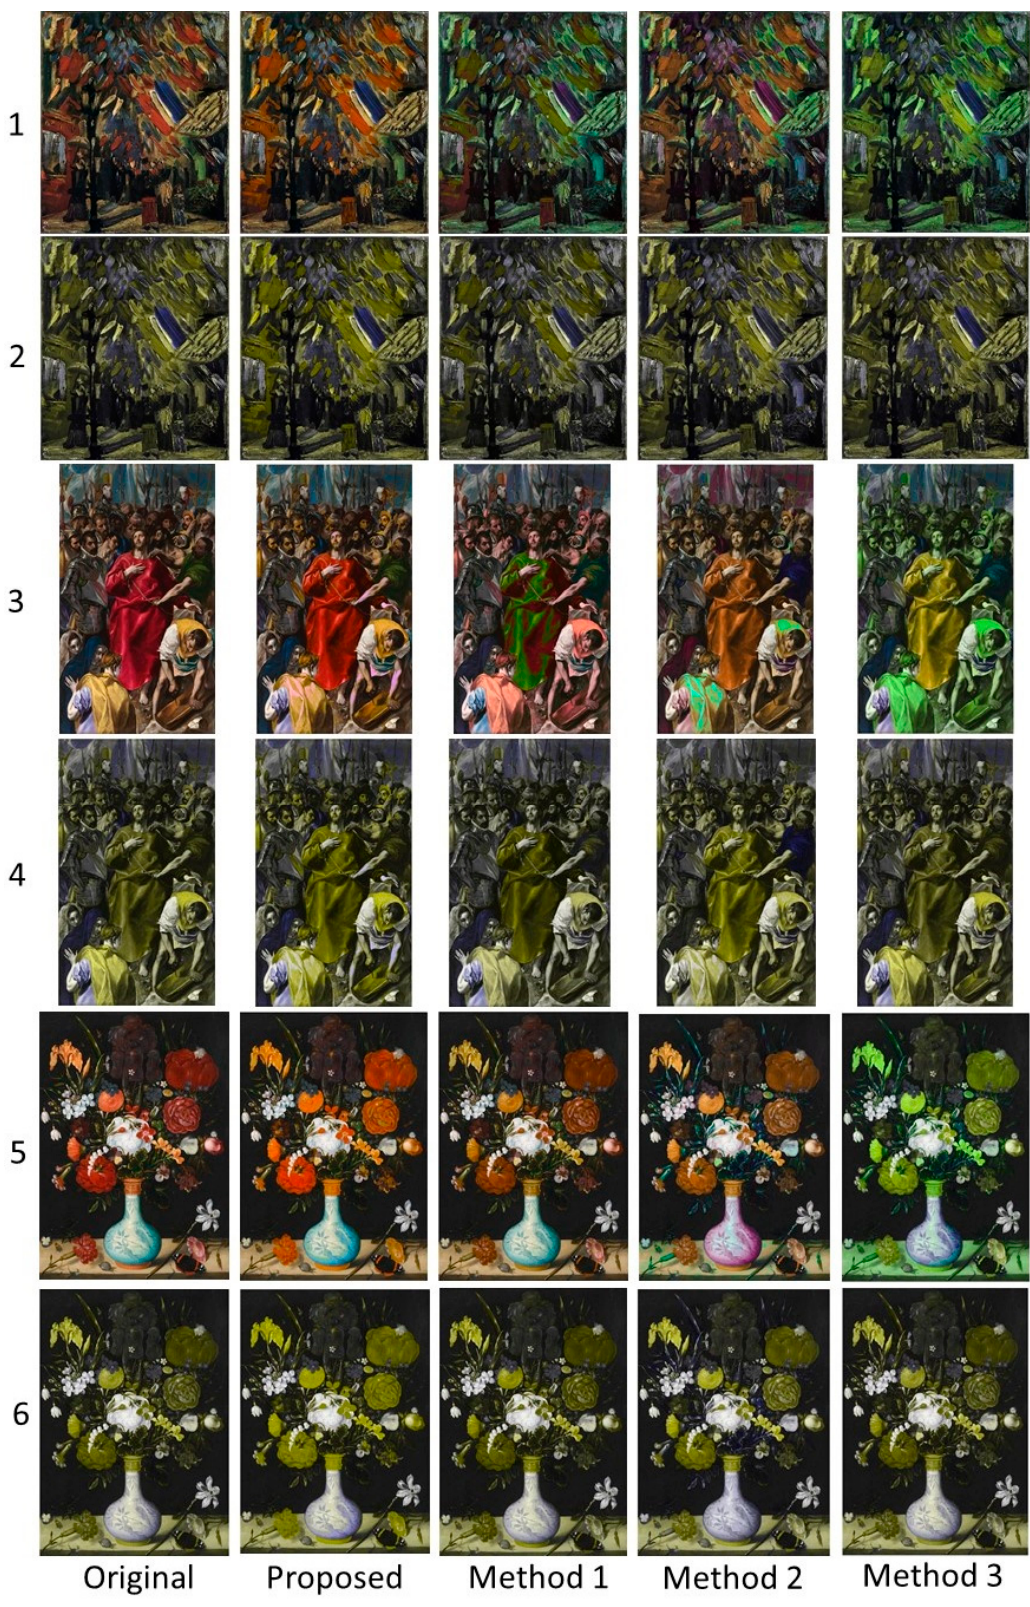
Figure 10. Qualitative comparison for deuteranopia using Paintings ( 2 , 5 , and 6 ). The original and the recolored paintings are given in rows ( 1 , 3 , and 5 ), while their respective deuteranope simulations are given in rows ( 2 , 4 , and 6 ).